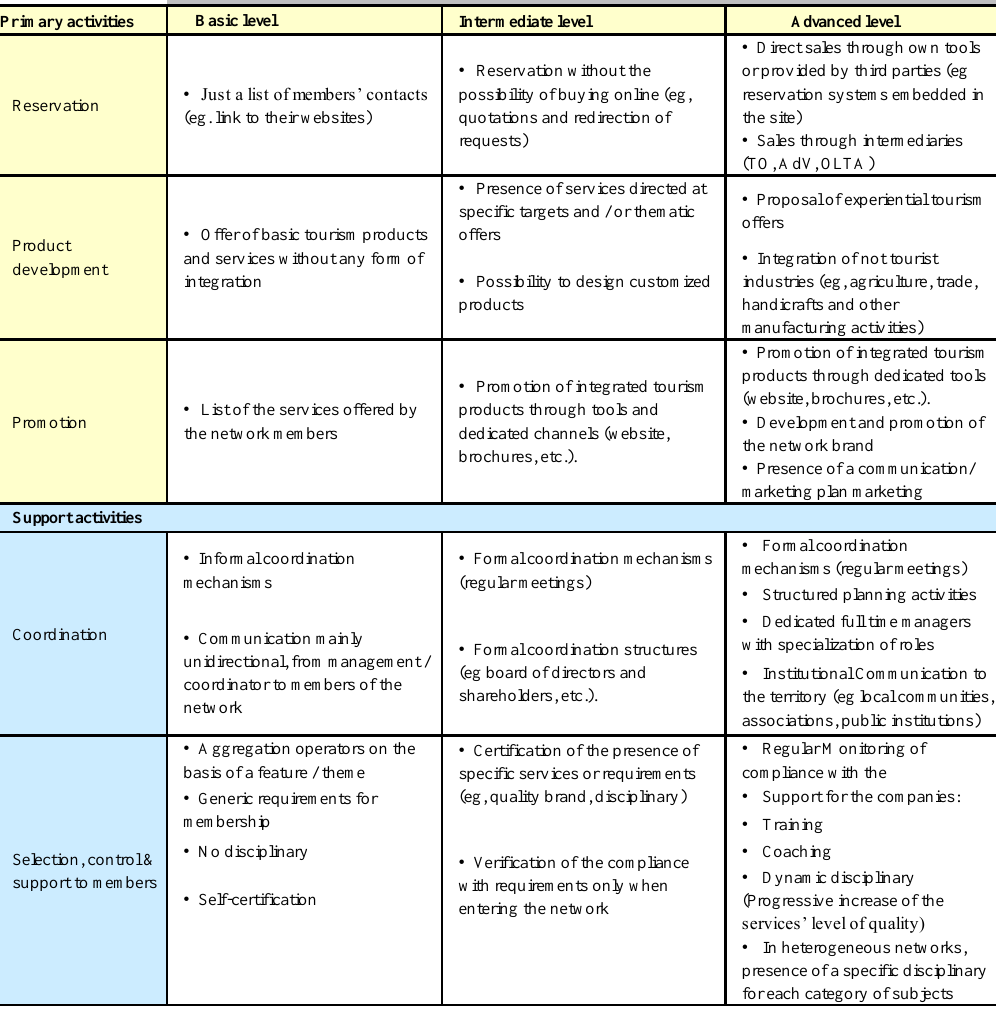
Table 4: The Network’s Matury Model Primary